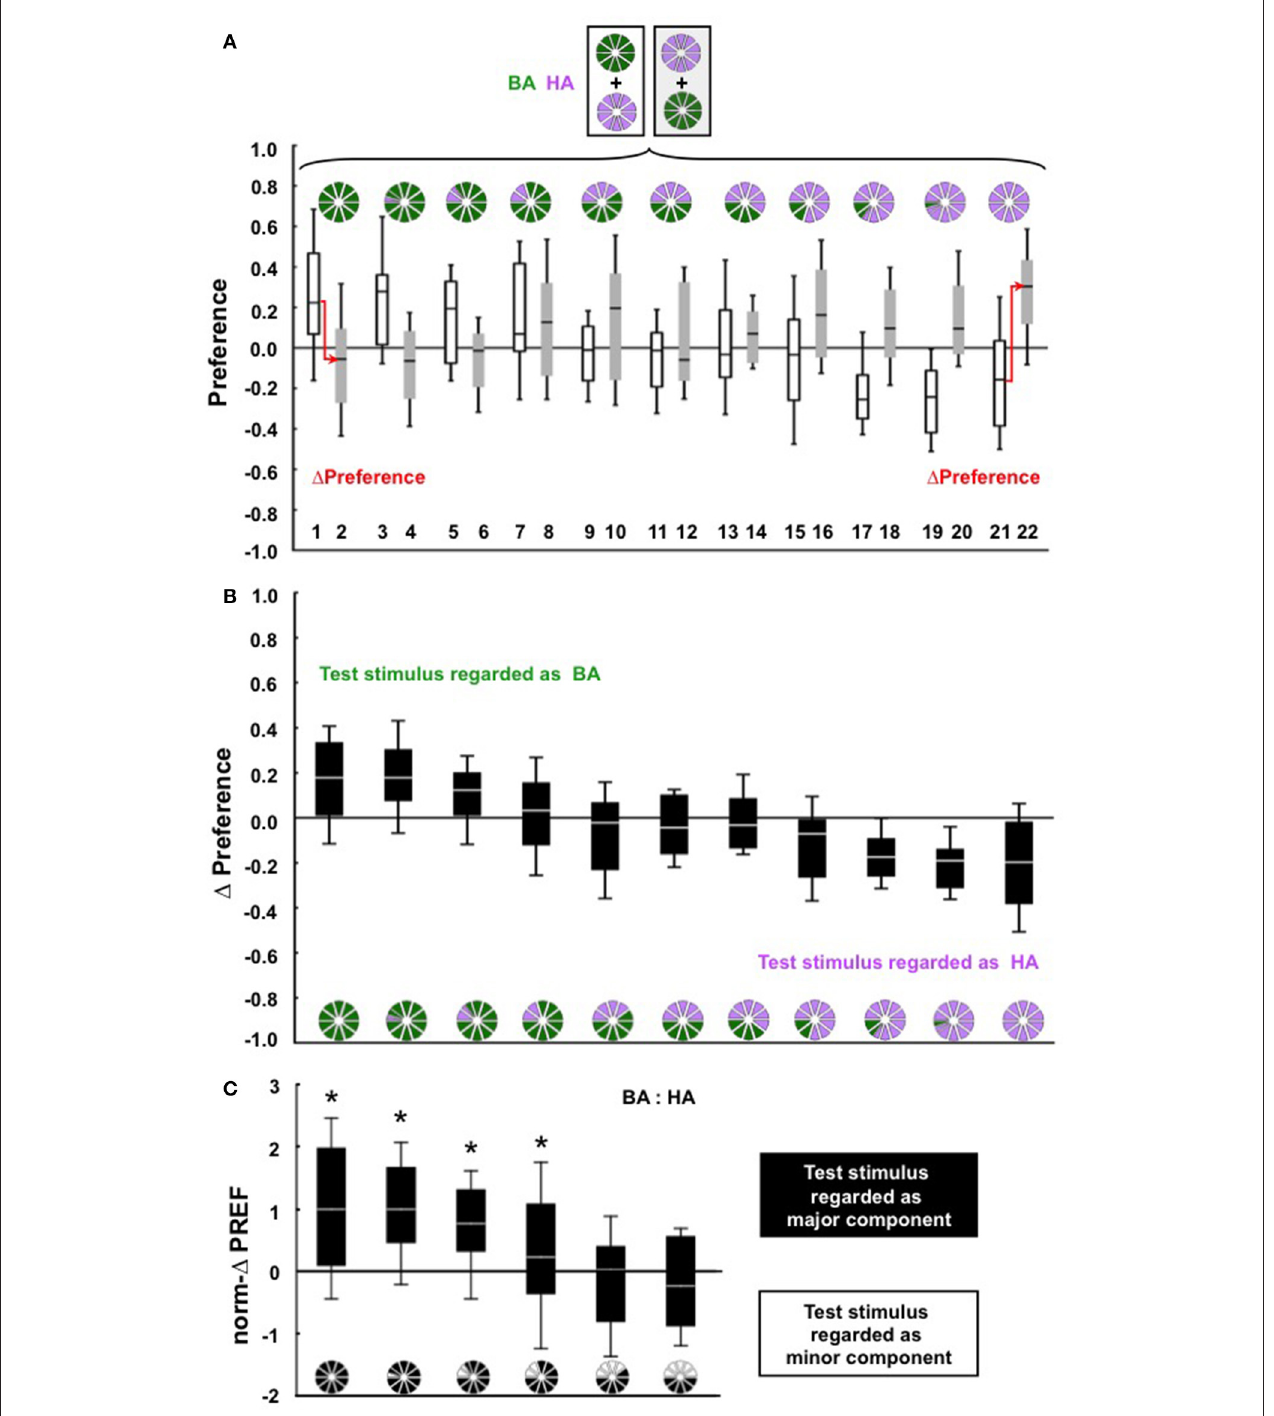
FIGURE 1 | (A) Larvae were differentially trained with BA and HA (shown on top), and were tested either for their preference for BA (groups 1 and 2), for their preference for HA (groups 21 and 22), or for their preference for mixtures of BA: HA at the ratio indicated by the pie graphs (groups 3–20). The key variable in this study was the relative proportions of BA and HA in the test mixture, by altering which we could see which of these mixtures the larvae regard as BA and which they regard as HA. Data are presented as box plots (median as bold line, 25/75% quartiles as box boundaries, and 10/90% quantiles as whiskers). For cohorts of n = 30 individual larvae each, the plots show the results from N = 40, 40, 20, 20, 20, 20, 40, 40, 20, 20, 20, 20, 20, 20, 40, 40, 20, 20, 20, 20, 40, 40 repetitions of the experiment from left to right. The arrows indicate that in order to measure associative recognition, the 1 Preference scores are calculated by subtracting